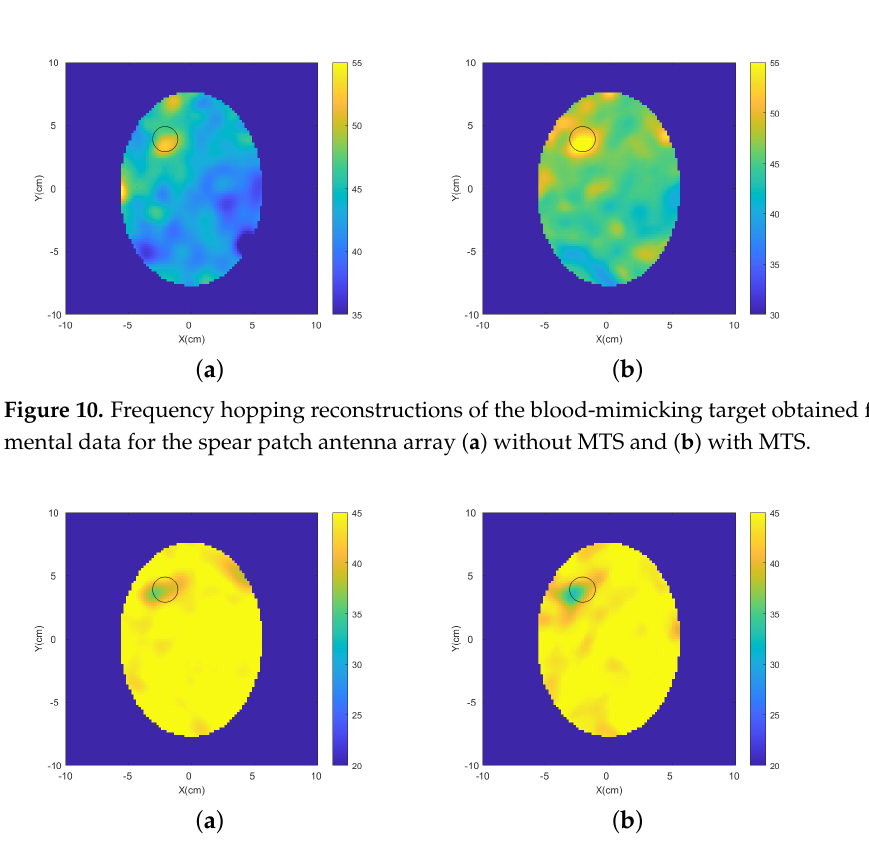
Figure 11. Frequency hopping reconstructions of the ischaemia-mimicking target obtained from experimental data for the spear patch antenna array ( a ) without MTS and ( b ) with MTS.